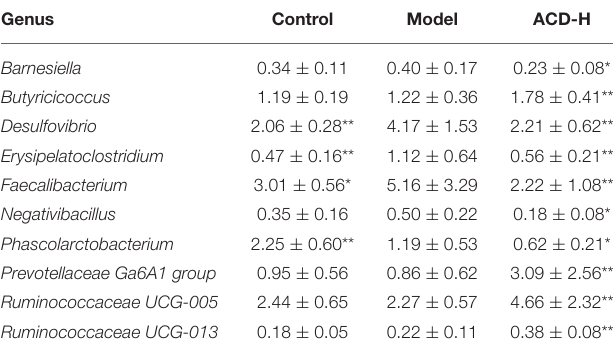
TABLE 3 | Relative abundance of rumen content microbiota at genus level ( n = 8).